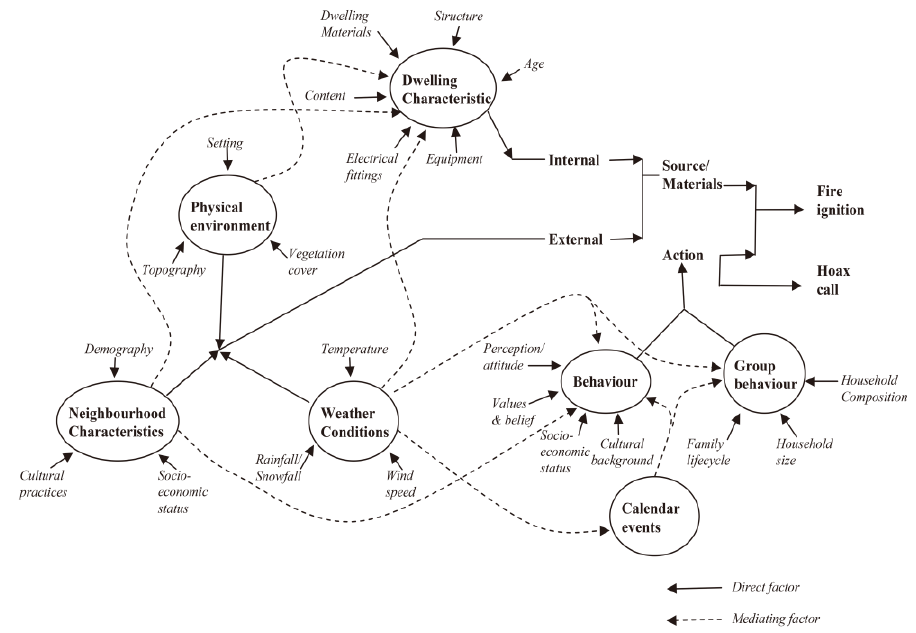
Figure 2. Conceptual model of fire risk [13]. (License No.: 4046910333494, permitted by Elsevier).